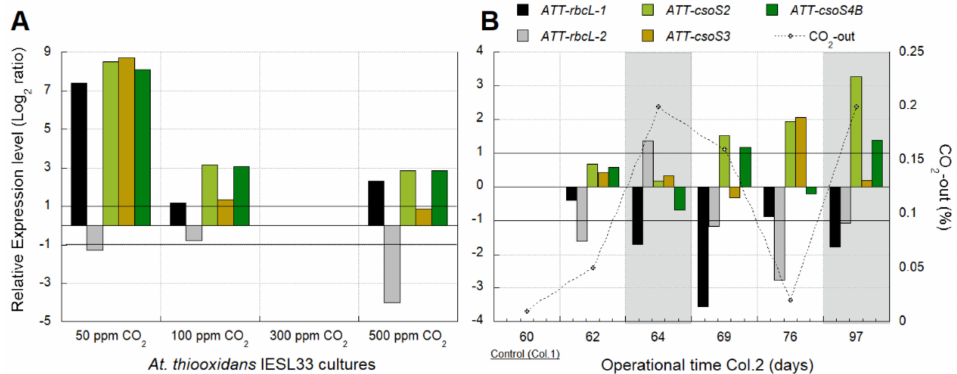
Figure 3. Transcriptional dynamics of five key Calvin–Benson–Basham (CBB) genes of At. thiooxidans (ATT) in response to ( A ) four different CO 2 supply conditions in pure cultures of the strain IESL-33 and to ( B ) variations in the CO 2 availability produced by three different interventions of input airflow in a controlled bioleaching column. Gray areas in the second graph show the two periods without input airflow in col.2 (days 63 to 68 and days 91 to 104). Significant differences in relative expression were adjusted at − 1 < Log 2 ratio < 1 (horizontal black lines). Gene expression was calculated relative to the control samples (log 0 values) that correspond in ( A , B ), respectively, to the culture with 300 ppm and the sample from operational day 60. In ( B ), the X-axis corresponds to operation days at the sampling time of